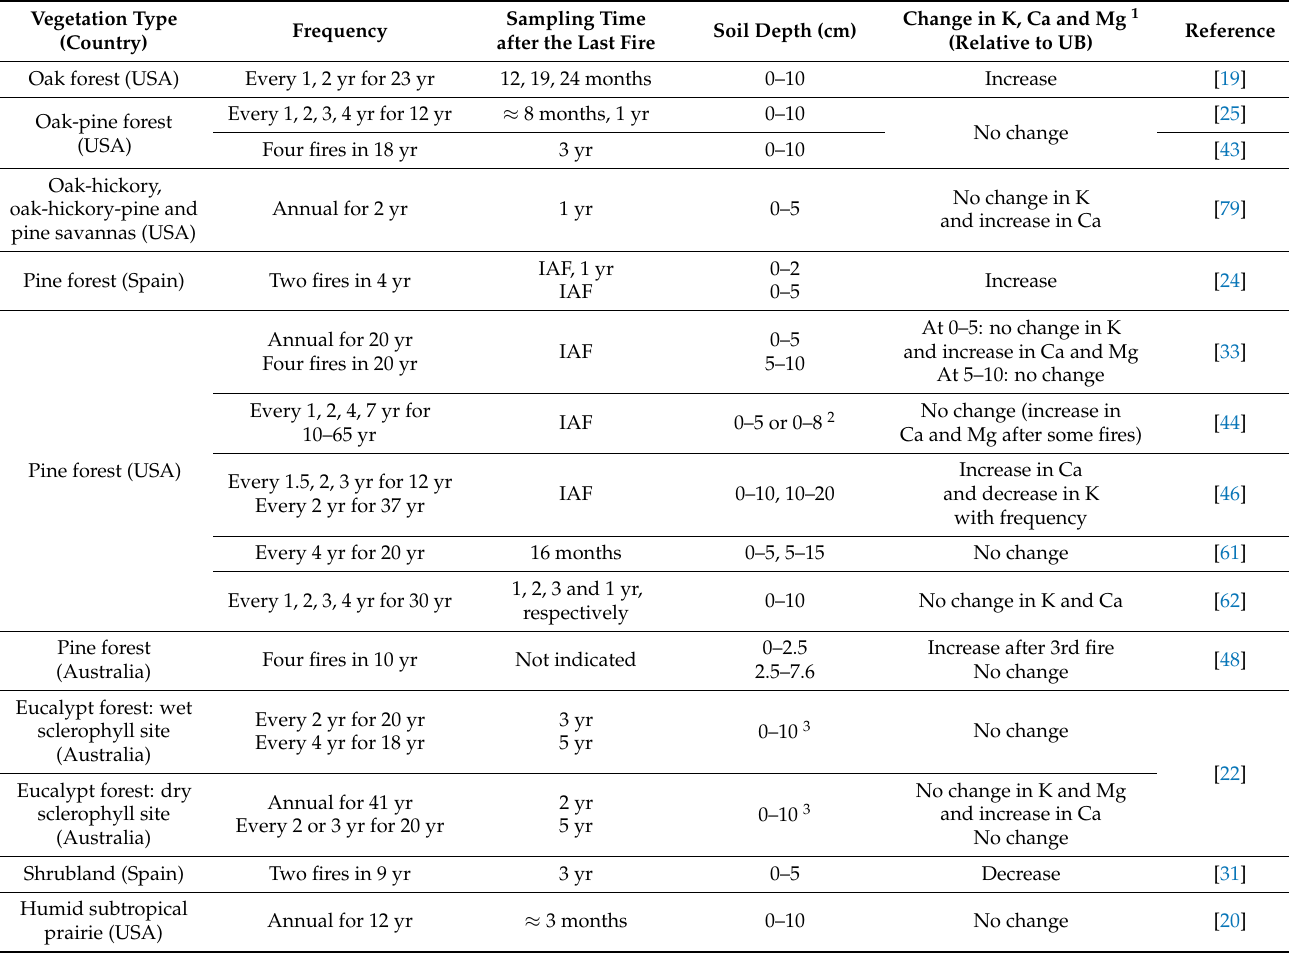
Table 7. Studies including the effects of repeated prescribed fires on soil macronutrients (extractable or exchangeable potassium -K-, calcium -Ca- and magnesium -Mg-). UB: unburned soil; yr: year; IAF: immediately after